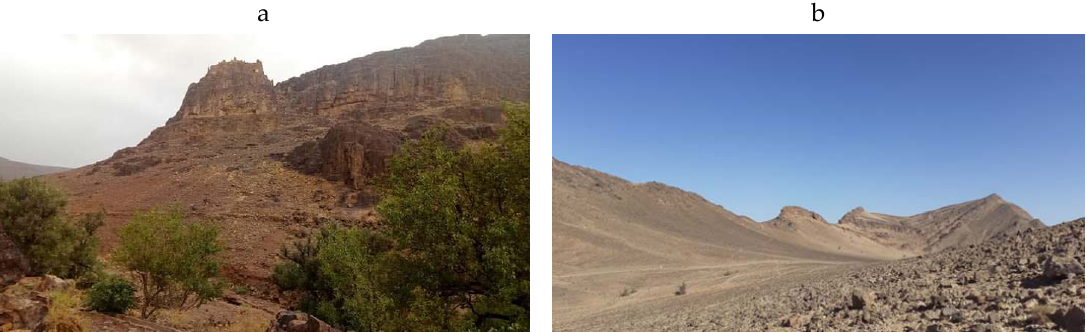
Figure 13. Observation of ( a ) Aguelmim Iznaghn area north-west of the Central Anti-Atlas sector and ( b ) Tafetchna area east of the Central Anti-Atlas sector. ( b ) Tafetchna area east of the Central Anti-Atlas